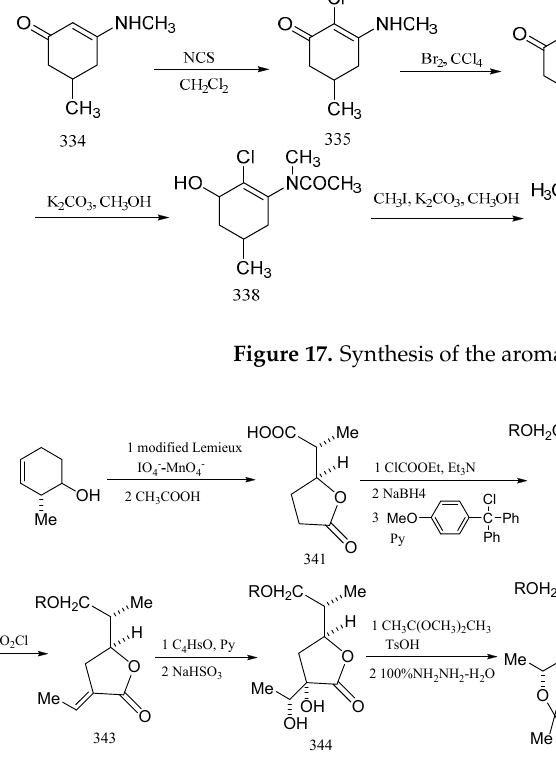
Figure 17. Synthesis of the aromatic portion of maytansine.